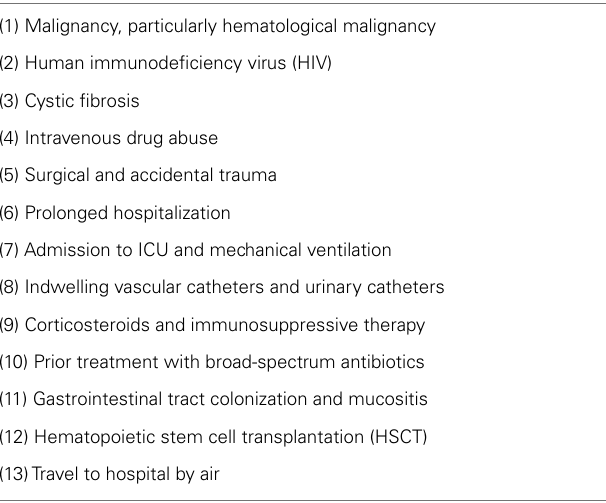
Table 1 | Risk factors for S. maltophilia infections in the general population .